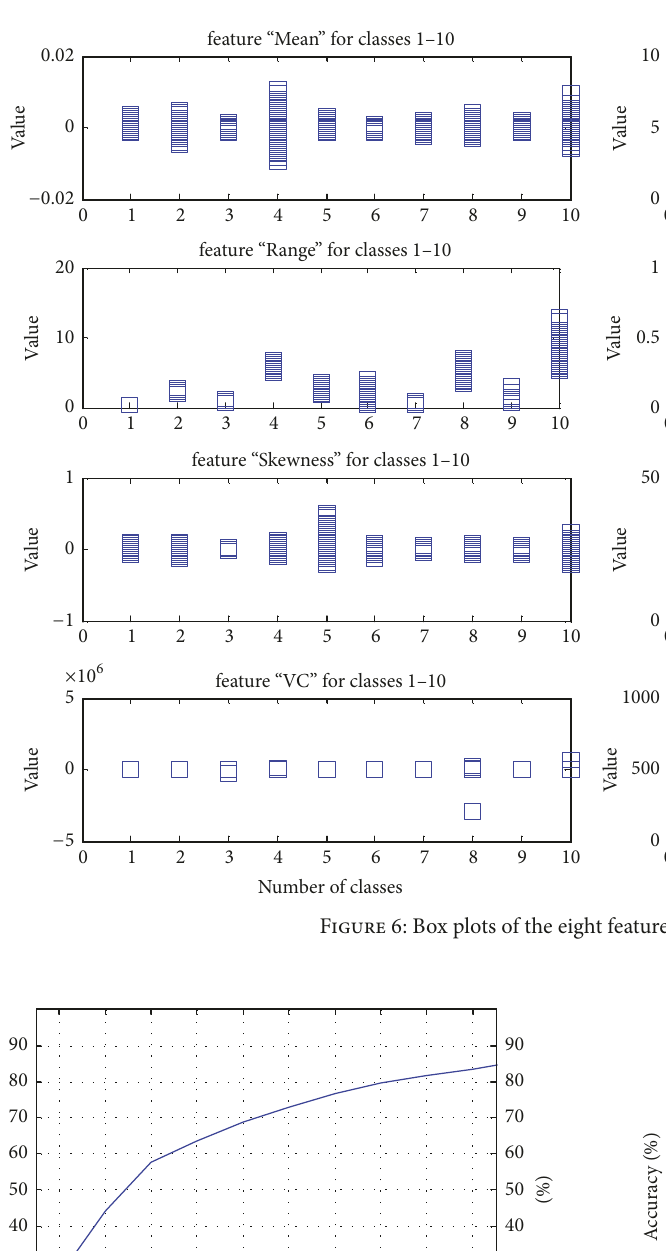
From Figures 8 and 9, MSVM classification recognition rate has a greater impact when 𝐶 and 𝛾 vary over a con- siderable range. The lowest classification rate is only around 18%. Accordingly, use particle parameter adaptive method to optimize MSVM kernel parameters 𝛾 and regularization parameter 𝐶 . The parameters of PPA can be seen in Table